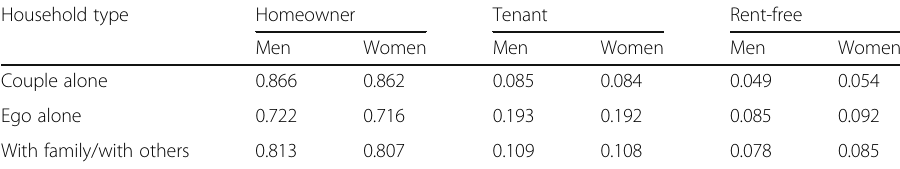
Table 4 Gender-specific predicted probability of being homeowner, tenant, and rent-free, by household